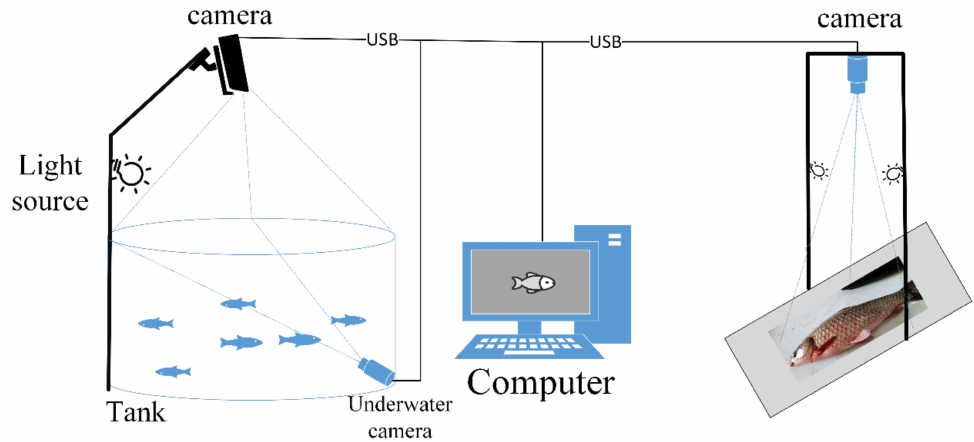
Figure 5. An architecture diagram of a computer vision-based fish disease diagnosis